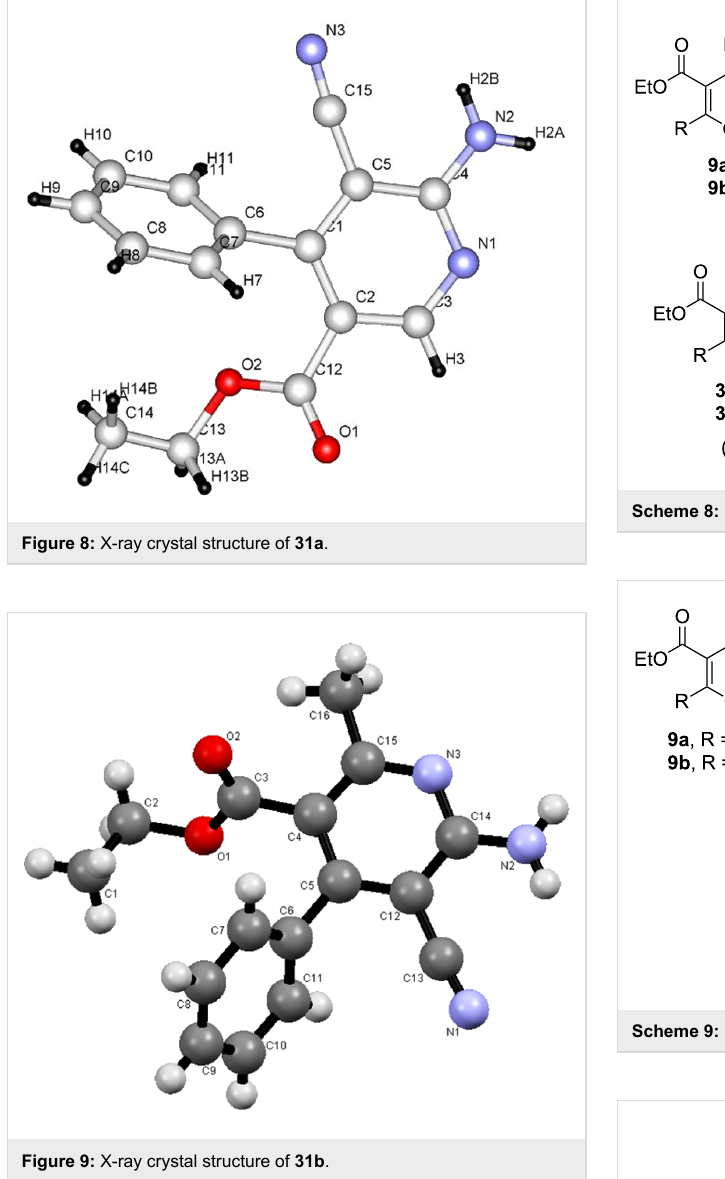
Figure 9: X-ray crystal structure of 31b .